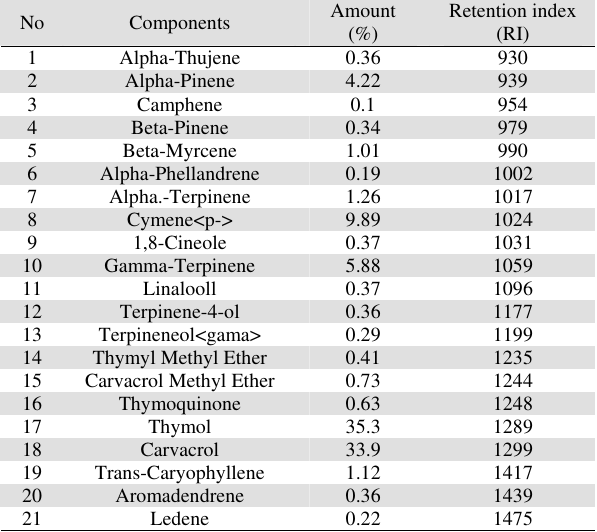
Table 1. Chemical composition of Z. multiflora essential oil